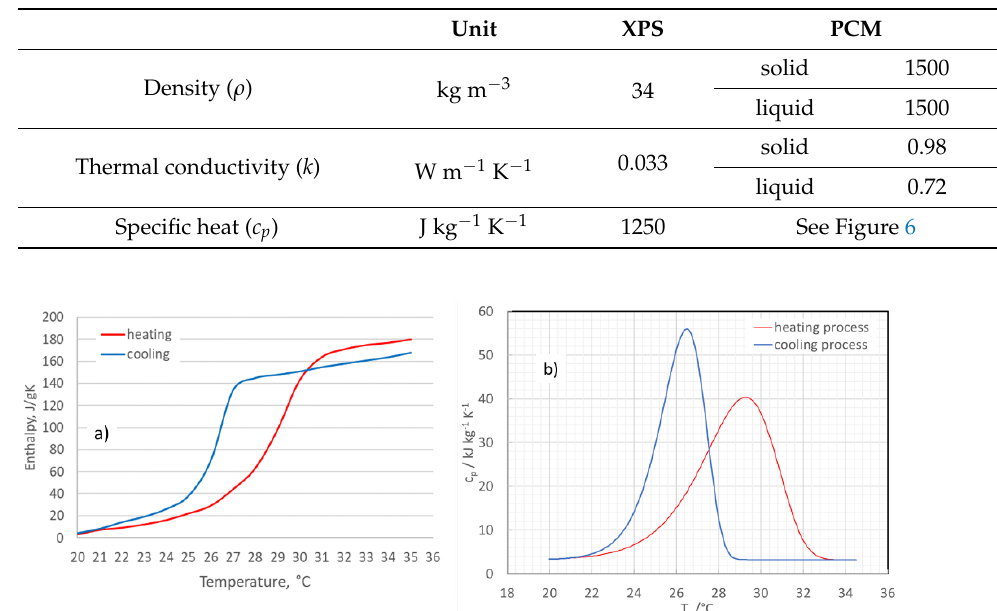
Table 1. Thermal properties of the wall materials (XPS and PCM) studied in the experiment.